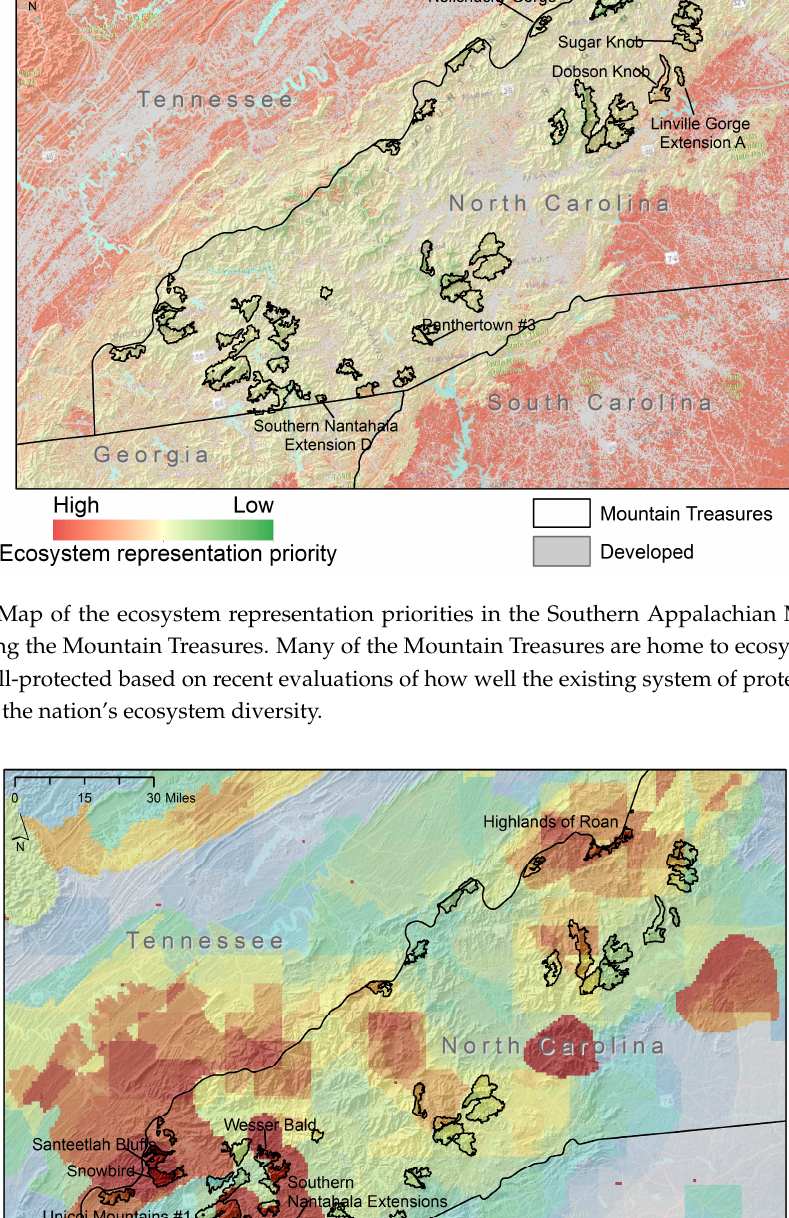
containing many range-limited species that are poorly represented in protected areas.